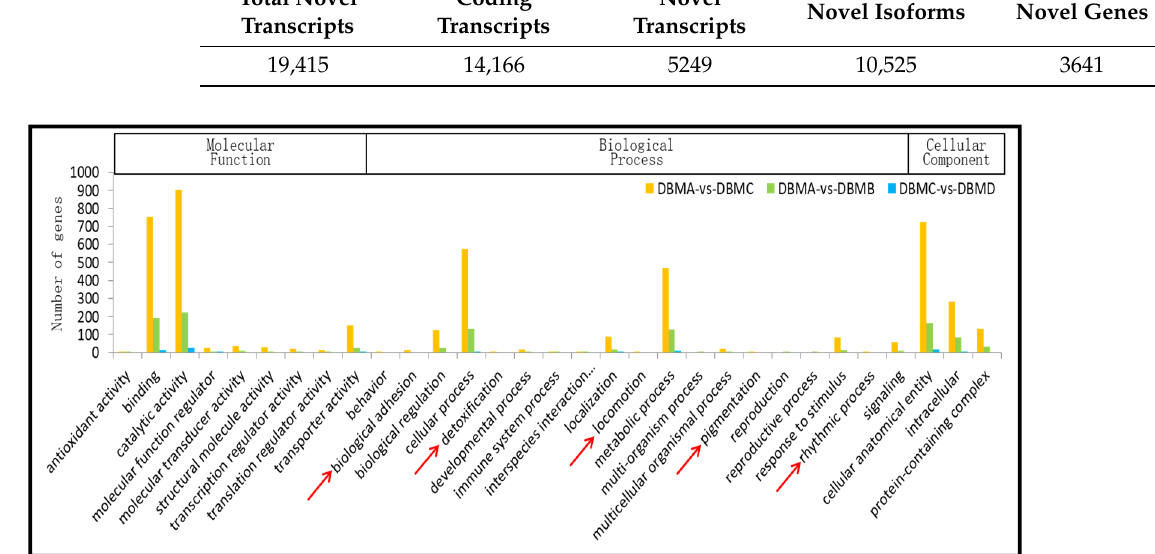
Table 2. Statistical summary of new transcript types.